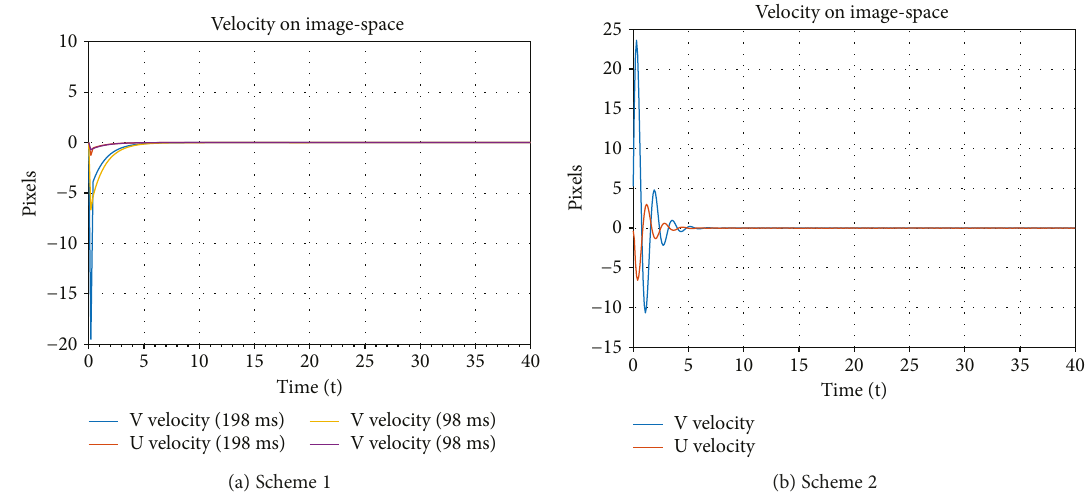
Figure 6: Velocity of the feature point on the image